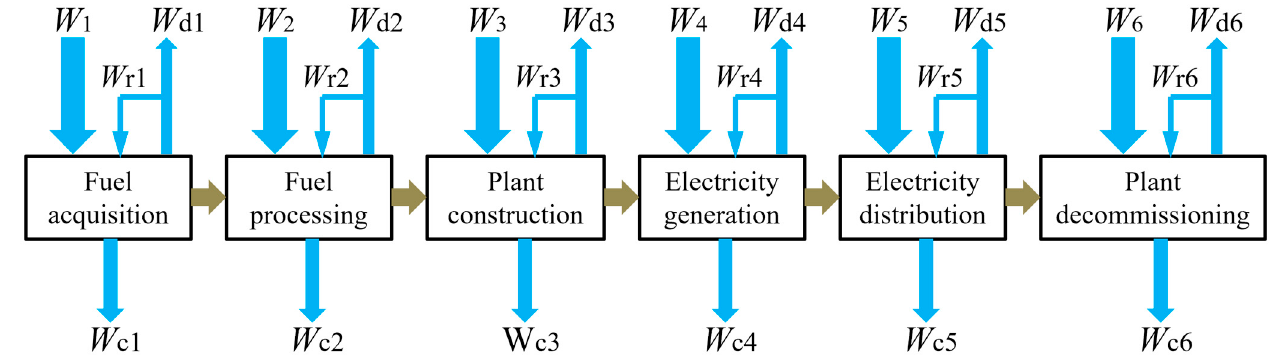
Figure 3. Water requirements in energy production chain (adapted after